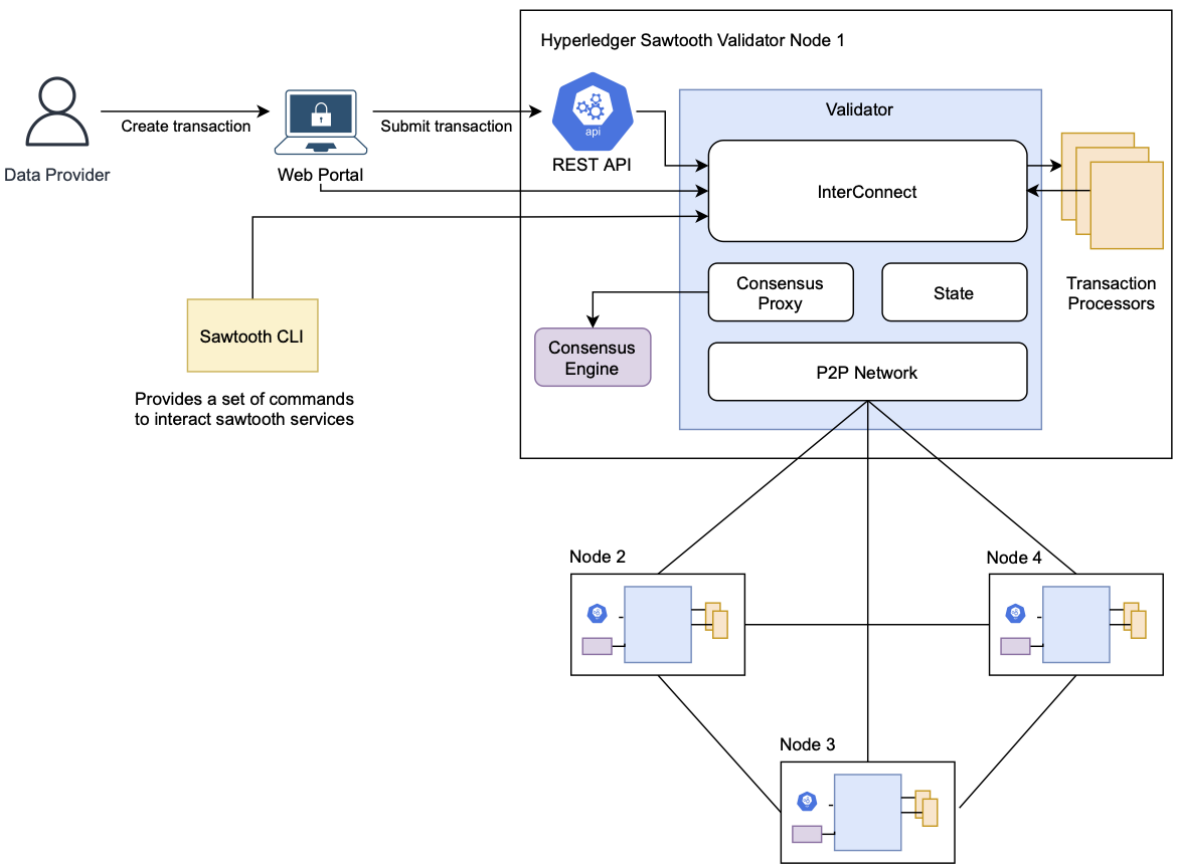
Figure 7. Hyperledger Sawtooth as the basis of the framework.